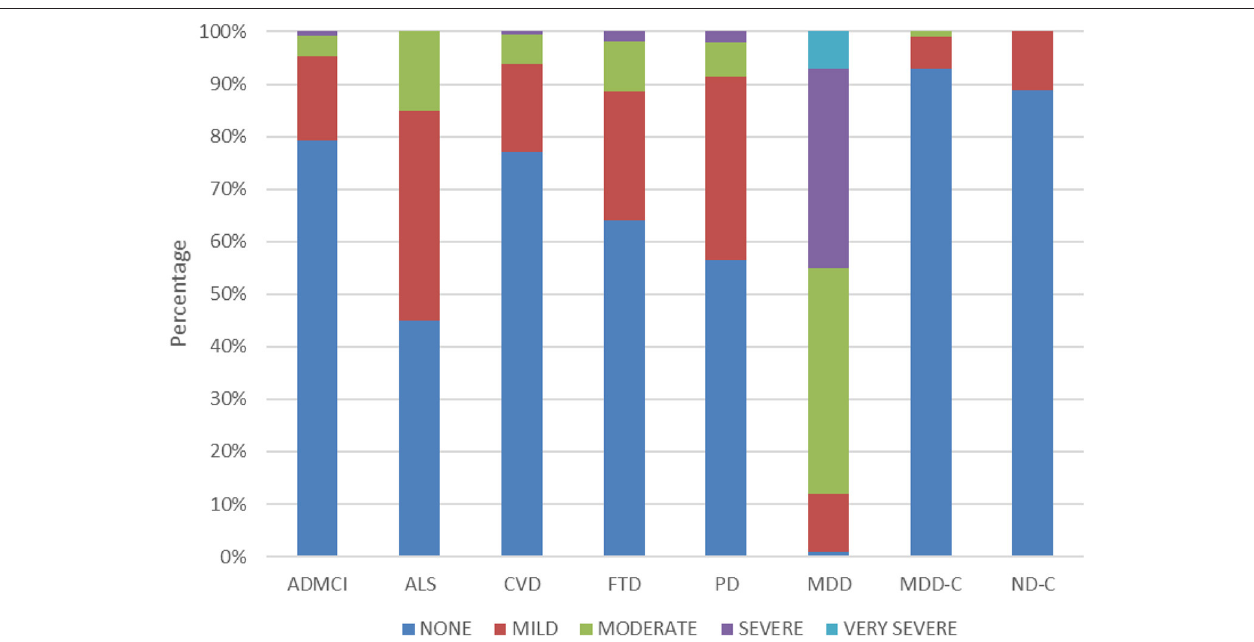
FIGURE 1 | Percentage of participants reporting no (total score ≤ 5), mild (total score = 6–10), moderate (total score = 11–15), severe (total score = 16–20), and very severe (total score ≥ 21) symptoms of depression in the QIDS-SR across the